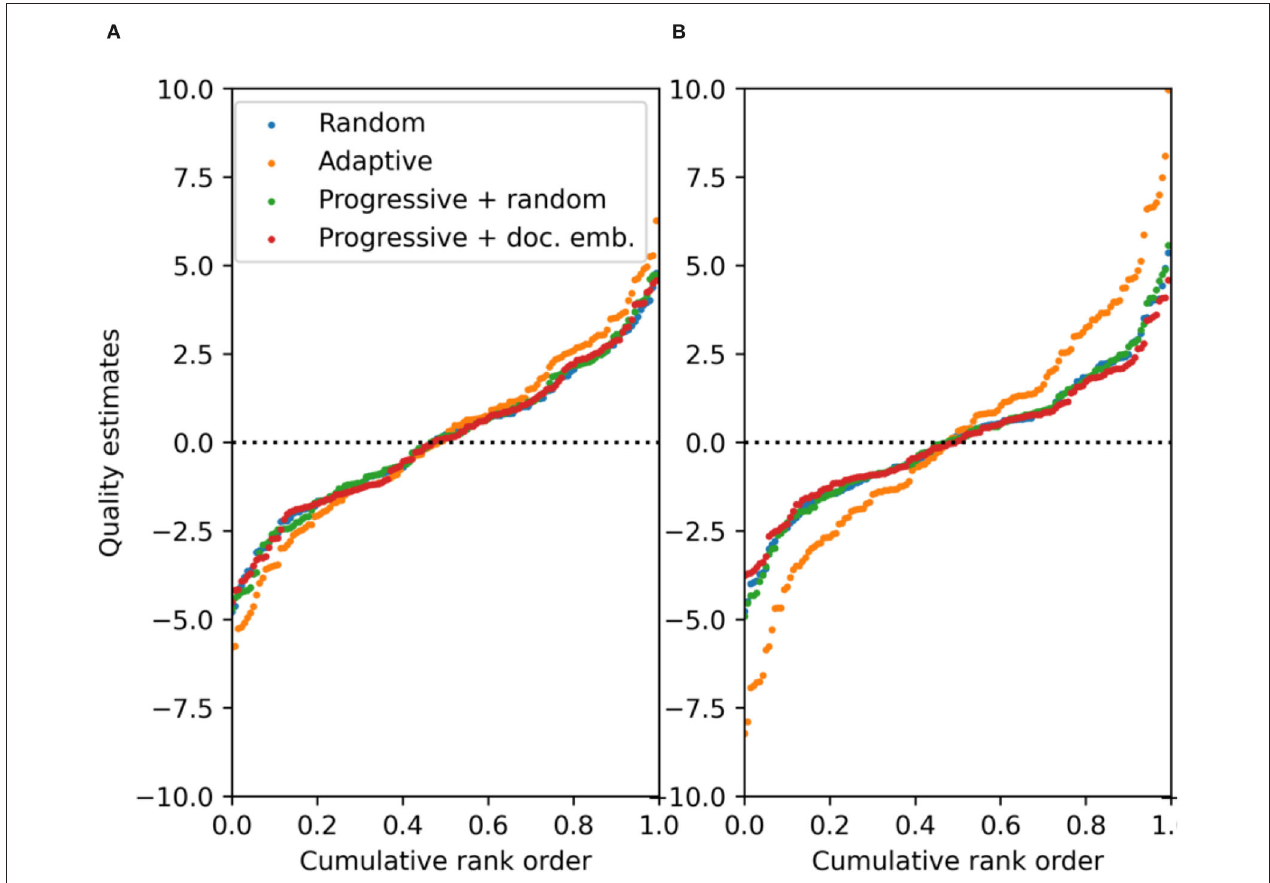
FIGURE 5 | For essay set 1 (N1 = 141), quality parameter estimates with respect to their cumulative ranking for 5 (A) and 10 (B) Comparisons per work on average. This is assessed for different selection rules: random (CJ), adaptive (ACJ), and a progressive selection with a random component and with a similarity component using document embeddings (100